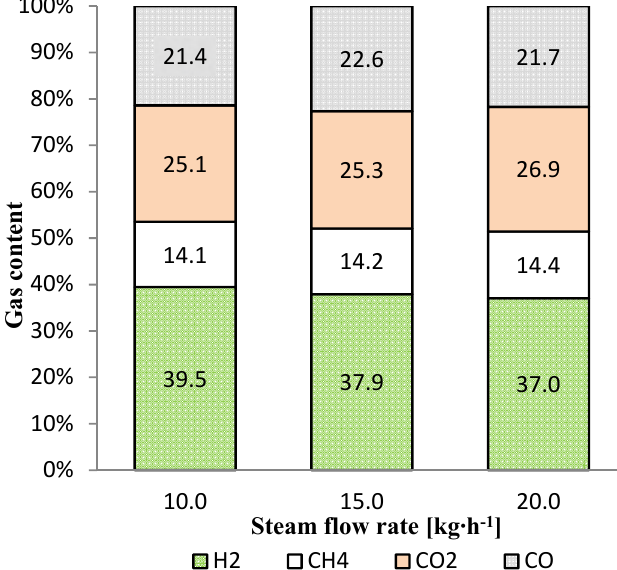
Figure 3. Impact of the rate of steam outflow on the composition of synthesis gas (the least significant difference at the significance level p < 0.05, for: H 2 = 1.0%, CH 4 = 0.4%, CO 2 = 0.8%, CO = 1.5%).